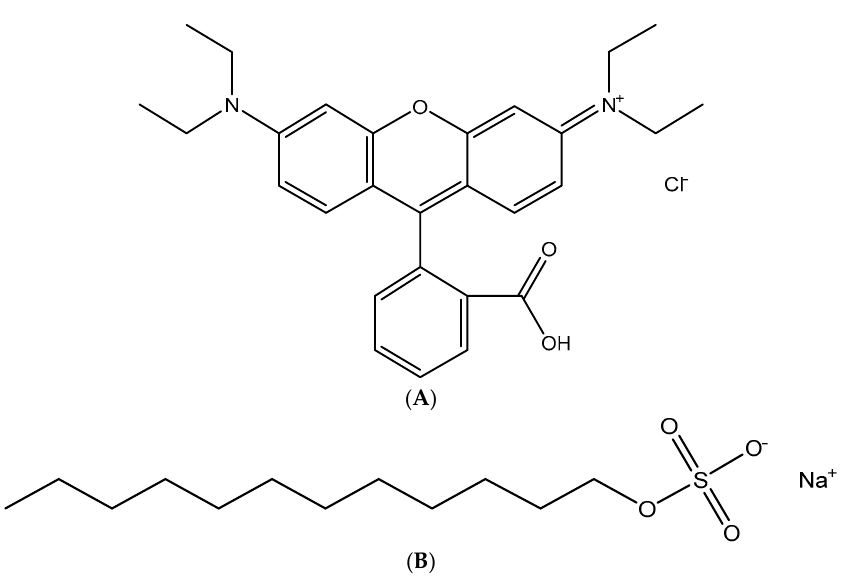
Figure 1. Chemical structures of Rhodamine B (RhB) ( A ) and sodium dodecyl sulfate (SDS) ( B ).